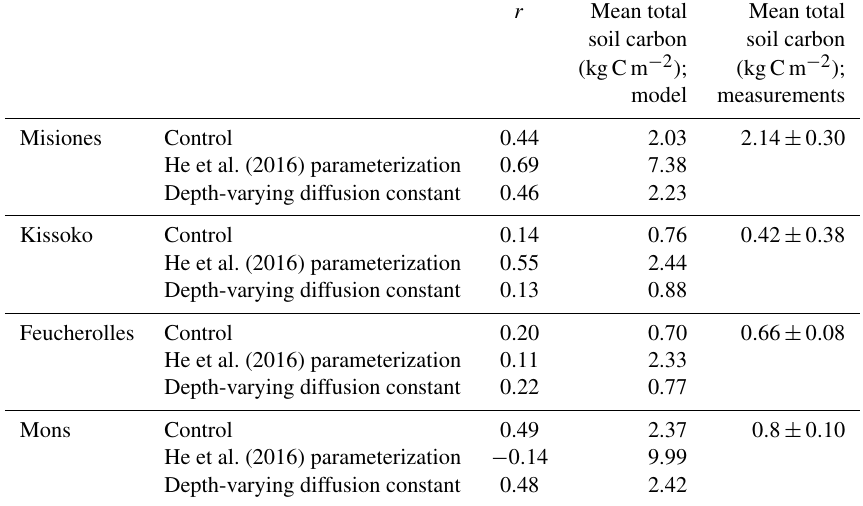
Table 3. The correlation coefficient ( r ) between model outputs and measurements for carbon stock (kgCm − 2 ) over the soil profile, for the four sites. The results of the initial version of the model ORCHIDEE-SOM- 14 C (Control), those from the version including the modification according to He et al. (2016) (He et al., 2016, parameterization) and diffusion varying according to depth (Depth-varying diffusion constant) are provided.